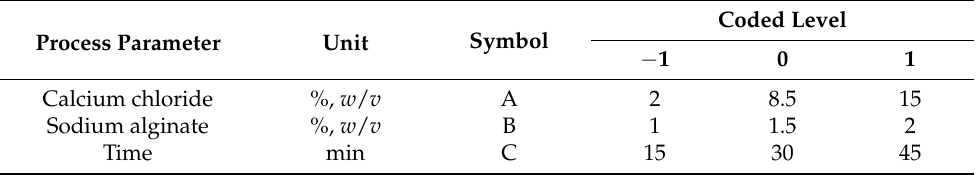
Table 1. Factors for the experimental design of the microencapsulation of the active substances in the sour cherry